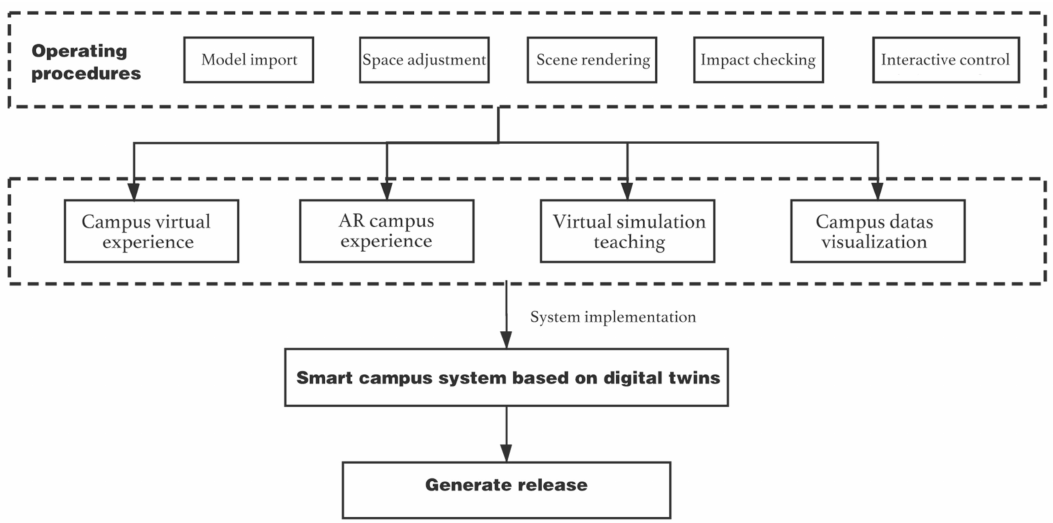
Figure 9. System